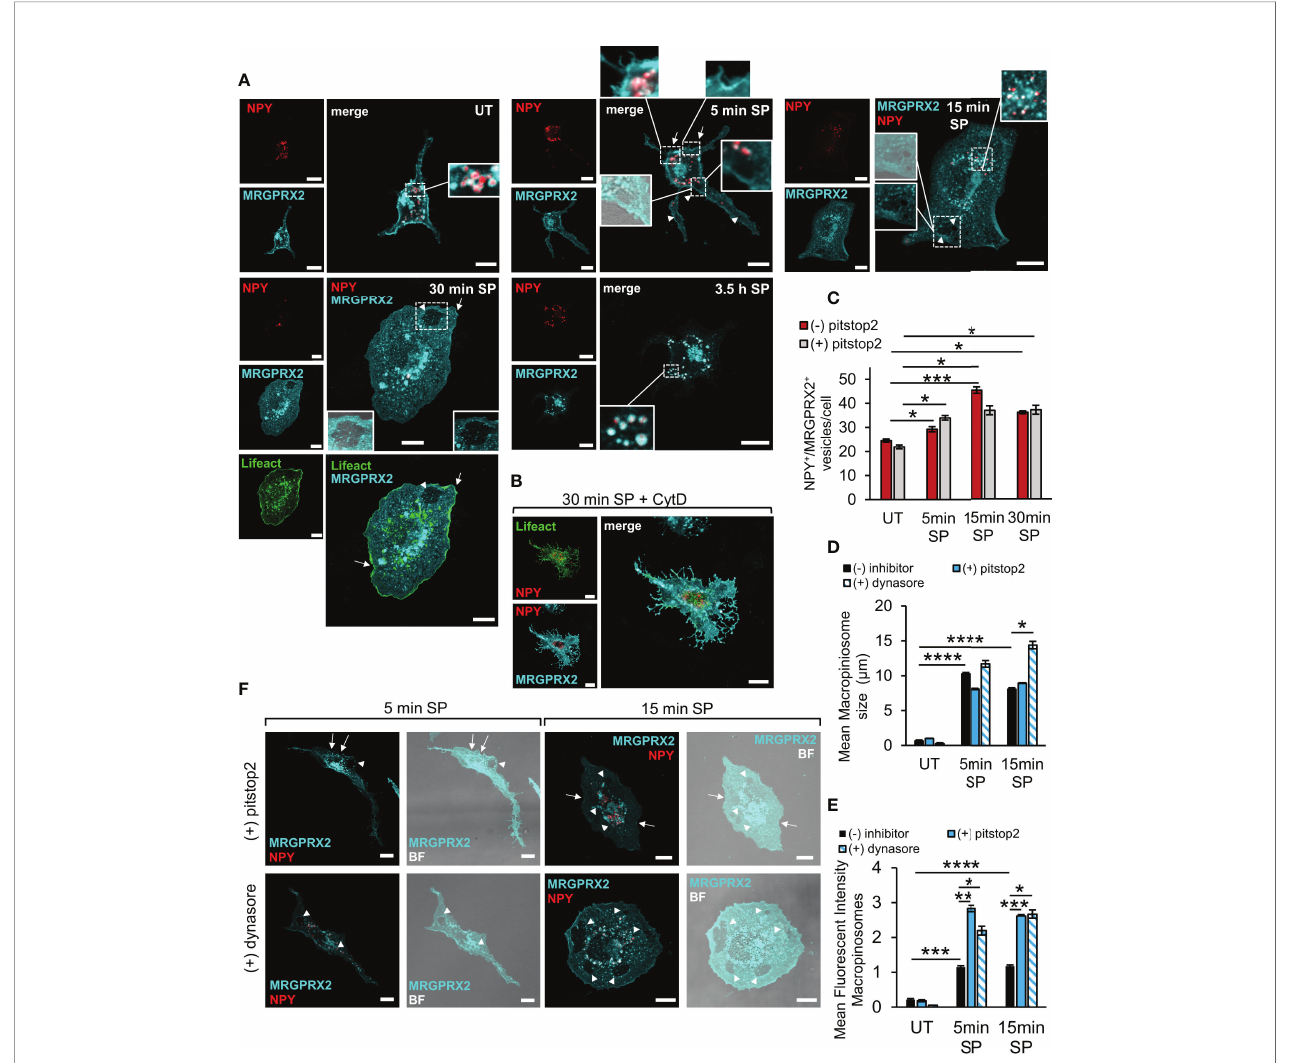
FIGURE 2 | Modes of MRGPRX2 internalization. RBL-MRGPRX2 cells, transiently transfected with NPY-mRFP (red) or NPY-mRFP and Lifeact-GFP (green), as indicated, were either left untreated (UT), or triggered with 10 µM SP for the indicated time periods, in the absence of inhibitor (A, C – E) , or following preincubation for 30 min with 10 µM CytD (B) , 20 µM pitstop2 (C, D – F) or 80 µM dynasore (D – F) , as indicated. Cells were immunostained with anti-HA antibodies, followed by Alexa Fluor ® 647-conjugated secondary antibodies (pseudo colored cyan). Enlargements correspond to the boxed areas. Macropinosomes are shown by the overlap with the bright fi eld (BF) image. Arrows point to MRGPRX2 that is localized to cell ruf fl es. Arrowheads point to macropinosomes. Scale bars = 10µm. The mean number of vesicles/cell that are double positive for NPY-mRFP and MRGPRX2 (NPY + /MRGPRX2 + ) (C) , the mean size of macropinosomes (D) , and the Mean Fluorescent Intensity (MFI) of macropinosome-associated MRGPRX2 (E) , were calculated as described under Materials and Methods. Results are the means ± SEM from three independent experiments for dynasore and four independent experiments for pitstop2, each experiment including at least 20 cells/condition. Statistical signi fi cance was determined by one – way ANOVA, followed by Dunnett ’ s post-test for C * P < 0.05, ** P < 0.01 and *** P < 0.001. Statistical signi fi cance was determined by unpaired two-tailed Student ’ s t-test for D, **** P [UT vs. 5 min SP] = 6.12552E-08, **** P [UT vs.15 min SP = 1.62931E-07, * P [15 min: SP vs. SP + dynasore] = 0.013, and for E, *** P [UT vs. 5 min SP] = 0.0001, **** P [UT vs. 15 min SP] = 2.01147E-05, * P [5 min: SP vs. SP + dynasore] = 0.042, ** P [5 min: SP vs. SP + pitstop2] = 0.0017, * P [15 min: SP vs. SP + dynasore] = 0.0171, *** P [15 min: SP vs. SP + pitstop2] =